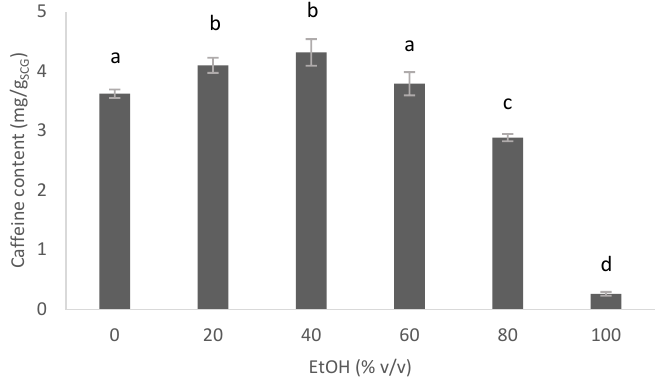
Figure 6. Influence of the EtOH/water ratio for the solid/liquid extraction of caffeine into spent coffee grounds (Experimental conditions: 2 g of SCG for 50 mL of hydroalcoholic solvent at 20 °C during 15 min, magnetically stirred). Values marked by the same letter are not significantly different ( p < 0.05) according to the Student test ( t- test).